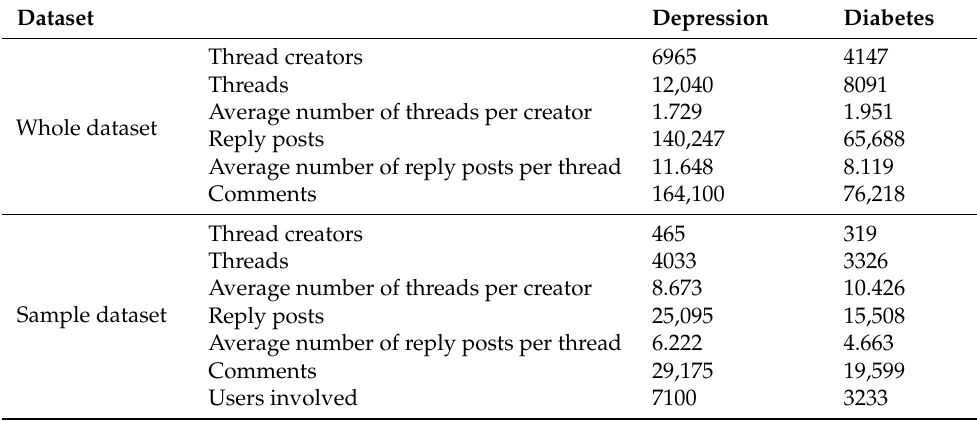
Table 2. Descriptive statistics of the whole dataset and sample